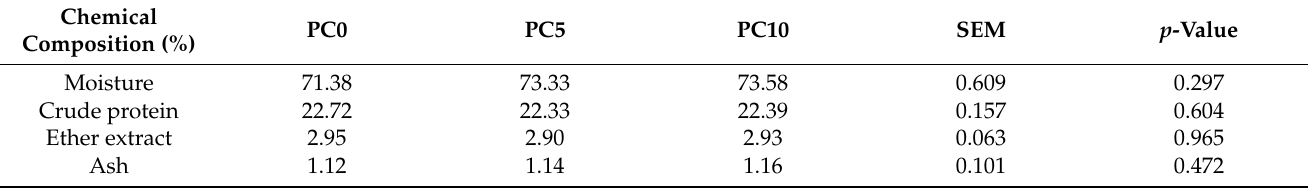
Table 5. Effect of dietary perilla cake supplementation on the chemical composition of the Longissimus dorsi of growing pigs.